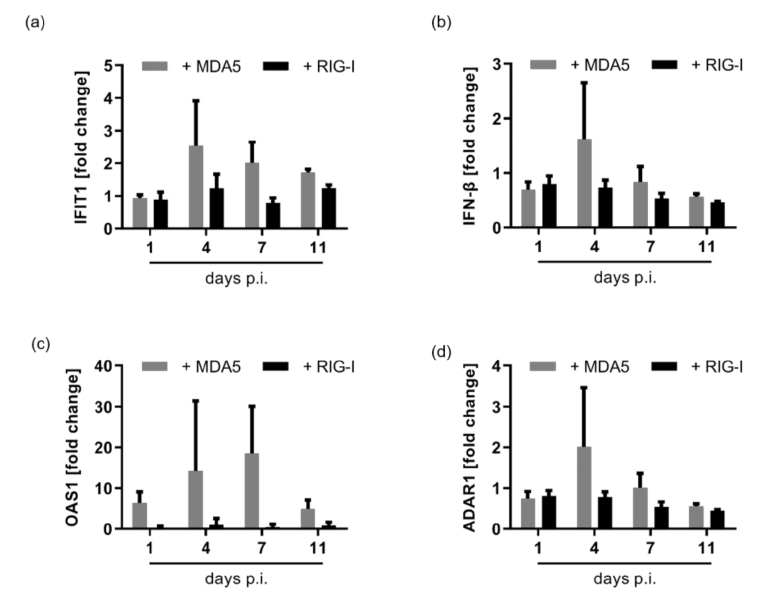
Figure A2. Western blot control of CRISPR-Knockout. HepG2-NTCP cells were subjected to CRISPR- knockout of RIG I, MDA5, MAVS and Signal transducer and activator of transcription 1 (STAT1, Western blot control). ( a ) Verification of MDA5, RIG I, MAVS and STAT1-knockout by Western blotting. MDA5-band is marked by arrow-head. Uncropped gels are shown. ( b ) Functional control of selected CRISPR-knockout cell lines upon stimulation experiment. Cells were stimulated as follows: 200 ng/well IVT4 (RIG I ligand) or transfected with 200 ng/well poly I:C, both RIG I and MDA5 ligand. Medium was collected 24 h post stimulation and CXCL10 ELISA was performed. Graph depicts a single experiment with technical duplicates.